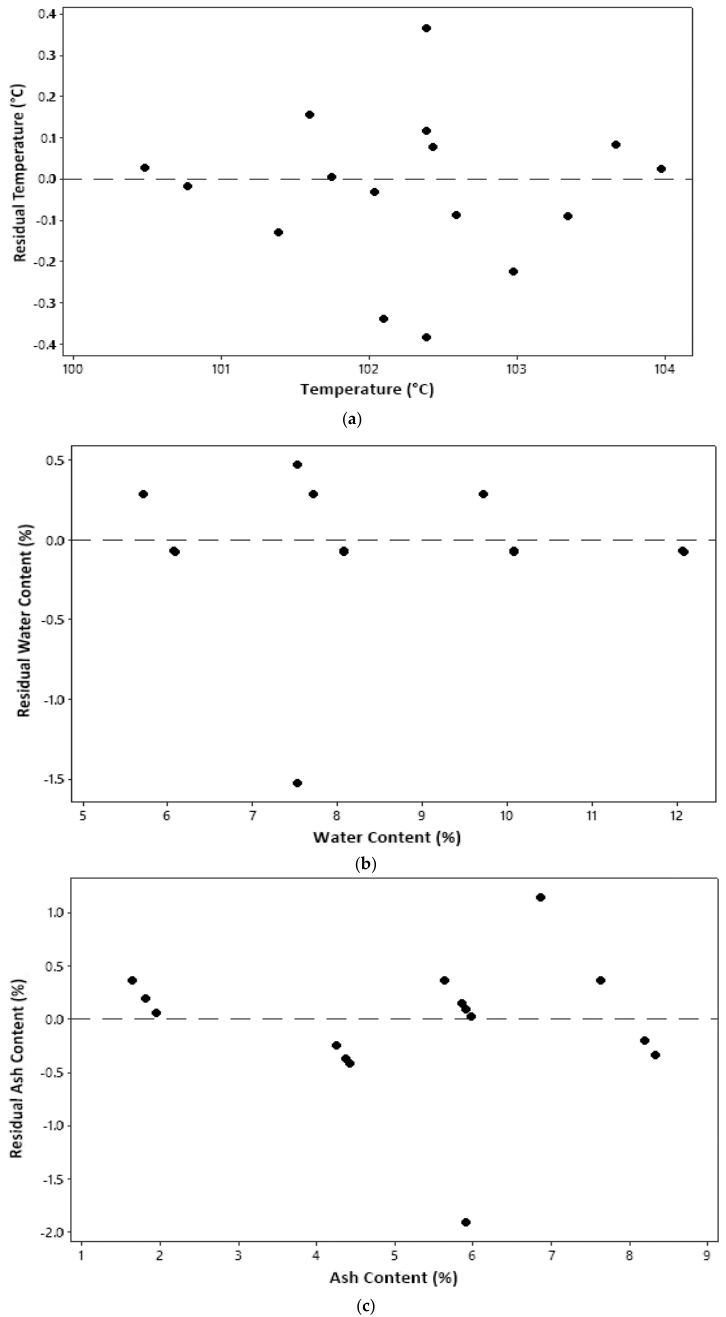
Figure 2. Identical assumption test: ( a ) temperature; ( b ) water content; ( c ) ash content.